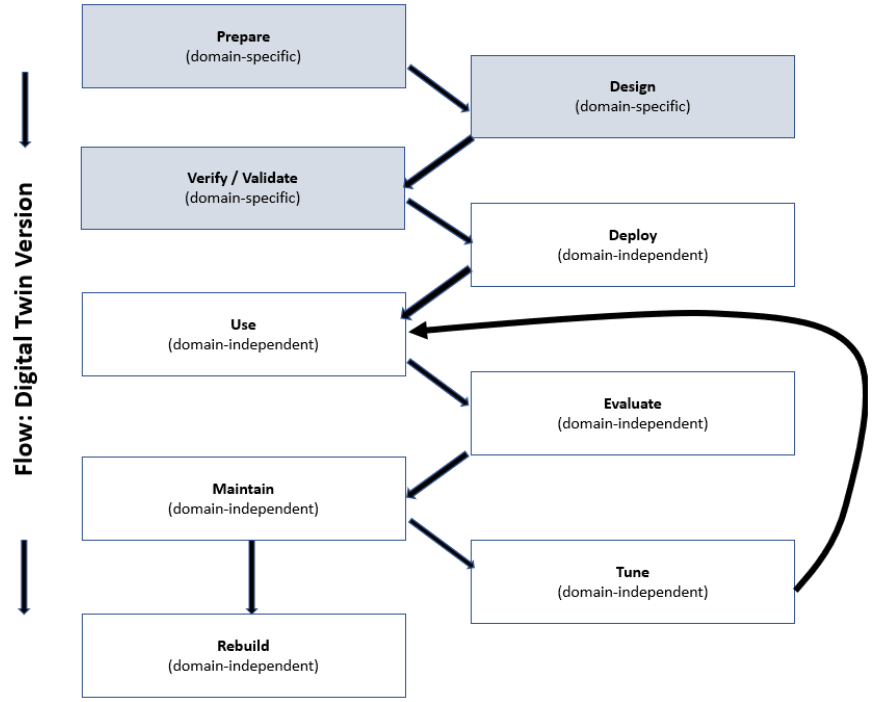
Figure 10. Sub-processes of integrated DT development model.